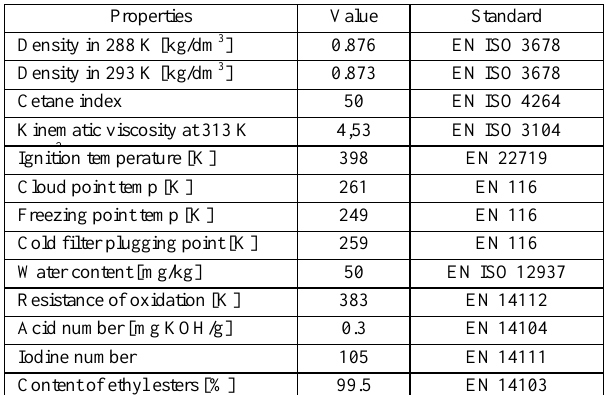
Table 1. Average properties of FAEE